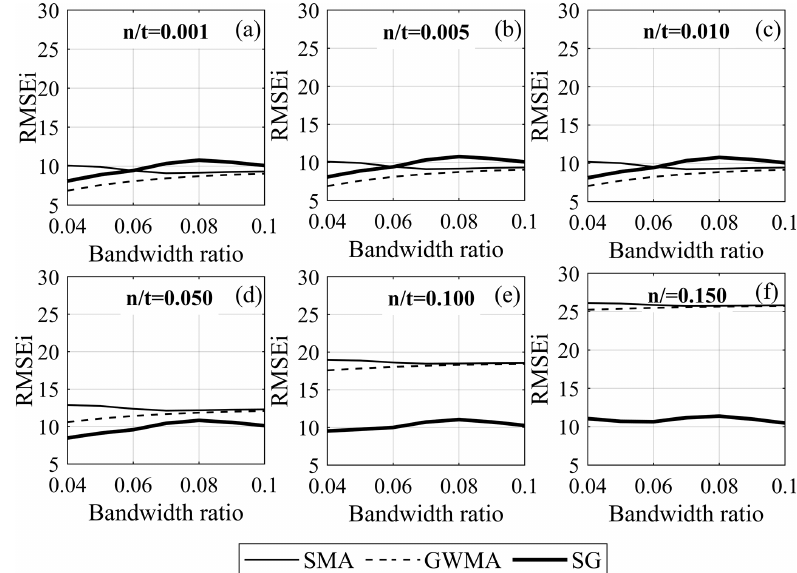
Figure 13. RMSEi for the instantaneous